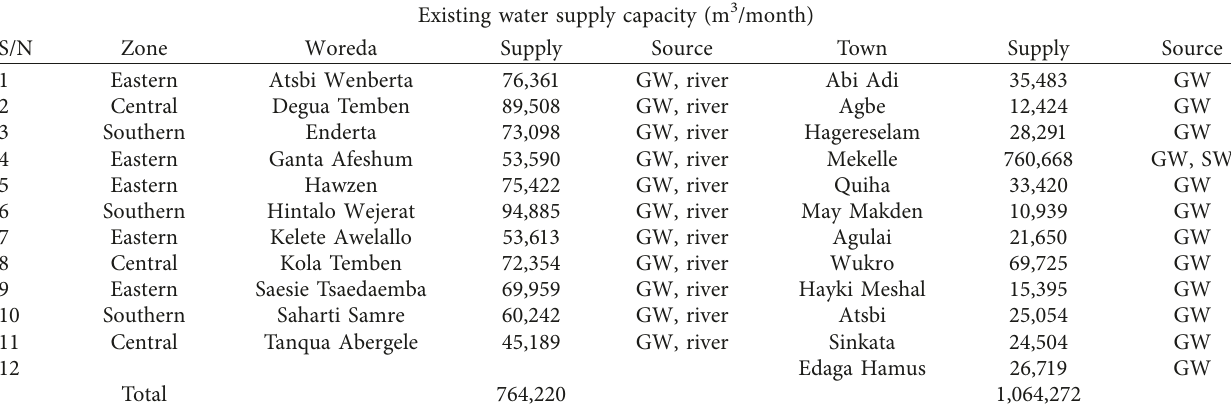
Table 4: Current water supply capacities of Woreda s and towns in the subbasin.